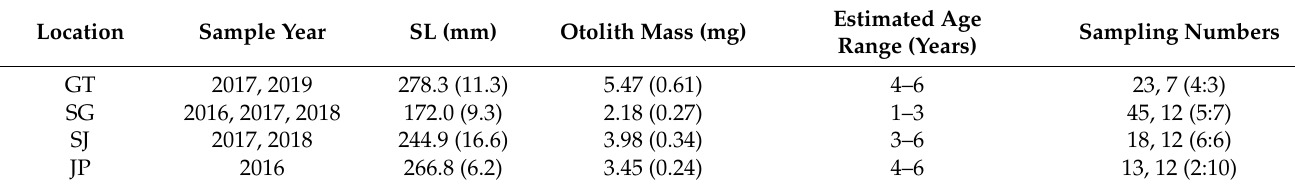
Figure 1. Sampling locations of Schizothorax kozlovi in the upper Yangtze River. Table 1. Summary table of Schizothorax kozlovi , collected in the upper Yangtze River.